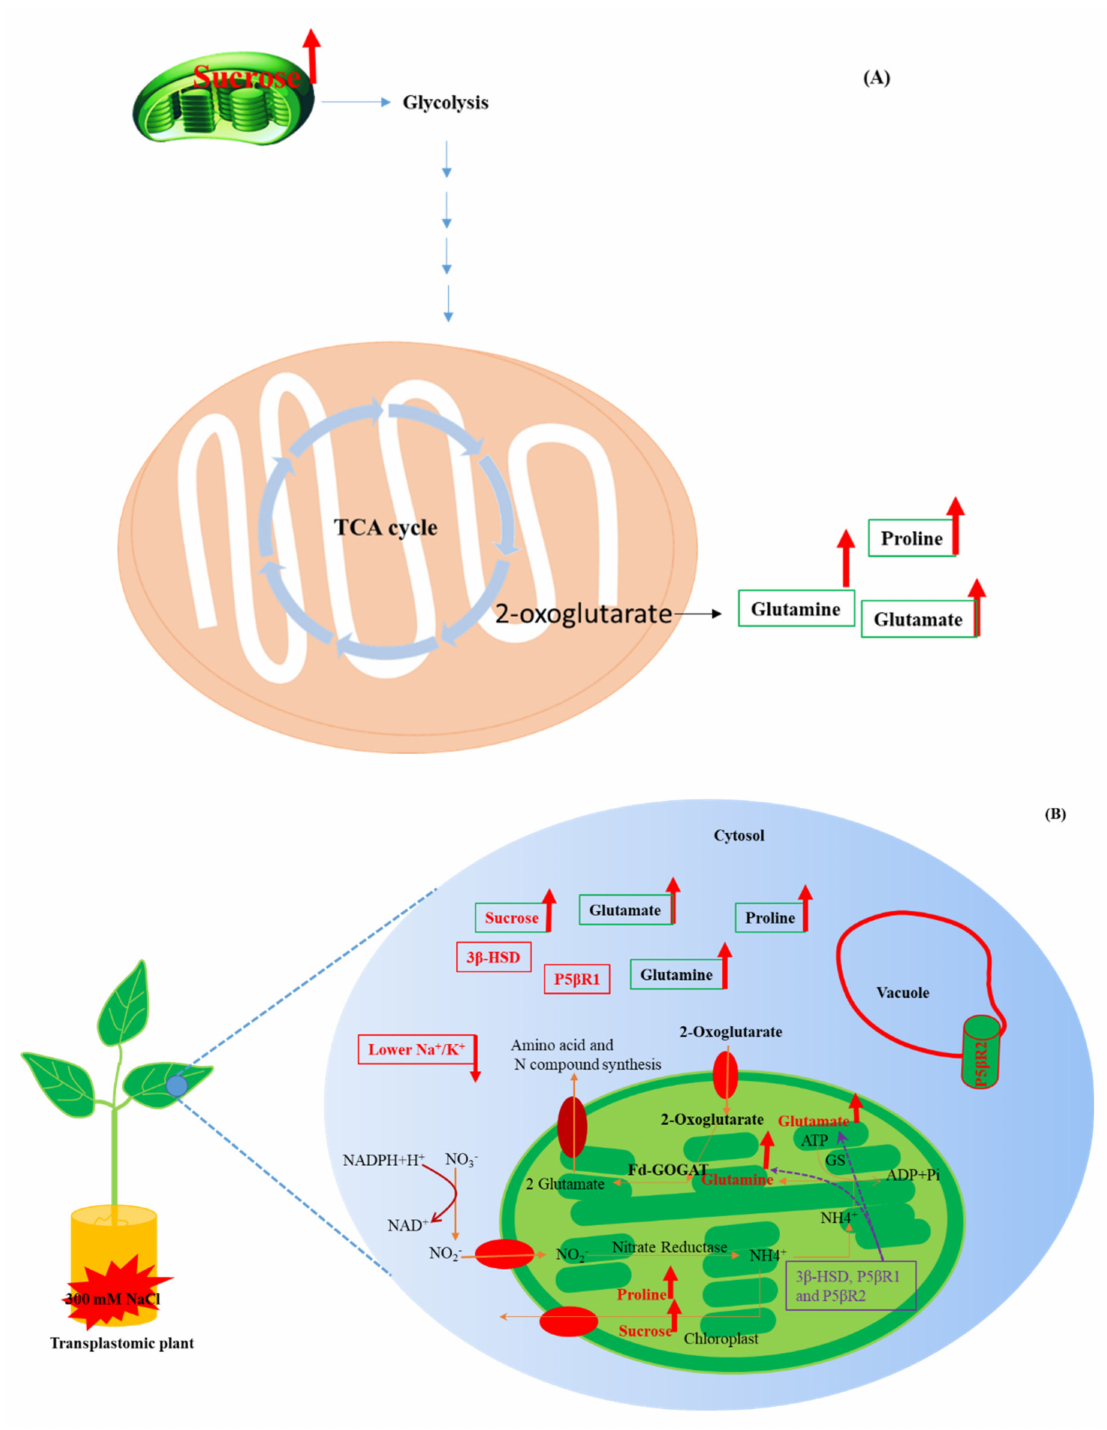
Figure 7. Improvement of salt tolerance in salt-stressed transplastomic plants of the 3 β -HSD , P5 β R1 and P5 β R2 due to enhanced synthesis of carbon-nitrogen skeleton metabolites and ionic balance. ( A ) Depicts the synthesis of carbon-nitrogen skeleton related metabolites due to induction of 300 mM NaCl in transplastomic plants. The genes 3 β -HSD , P5 β R1 and P5 β R2 seems to play an efficient role in synthesis of glutamate, glutamine, proline and sucrose. ( B ) Subcellular localization of the 3 β -HSD , P5 β R1 and P5 β R2 genes in cell and the accumulation of metabolites (sucrose, glutamate, glutamine and proline) or ionic balance (Na + /K + ) in the cell as a mechanism for salt tolerance. Bold red arrows upward show the metabolites which were enhanced and the bold red arrow downward represent decreased level of ion content under salt